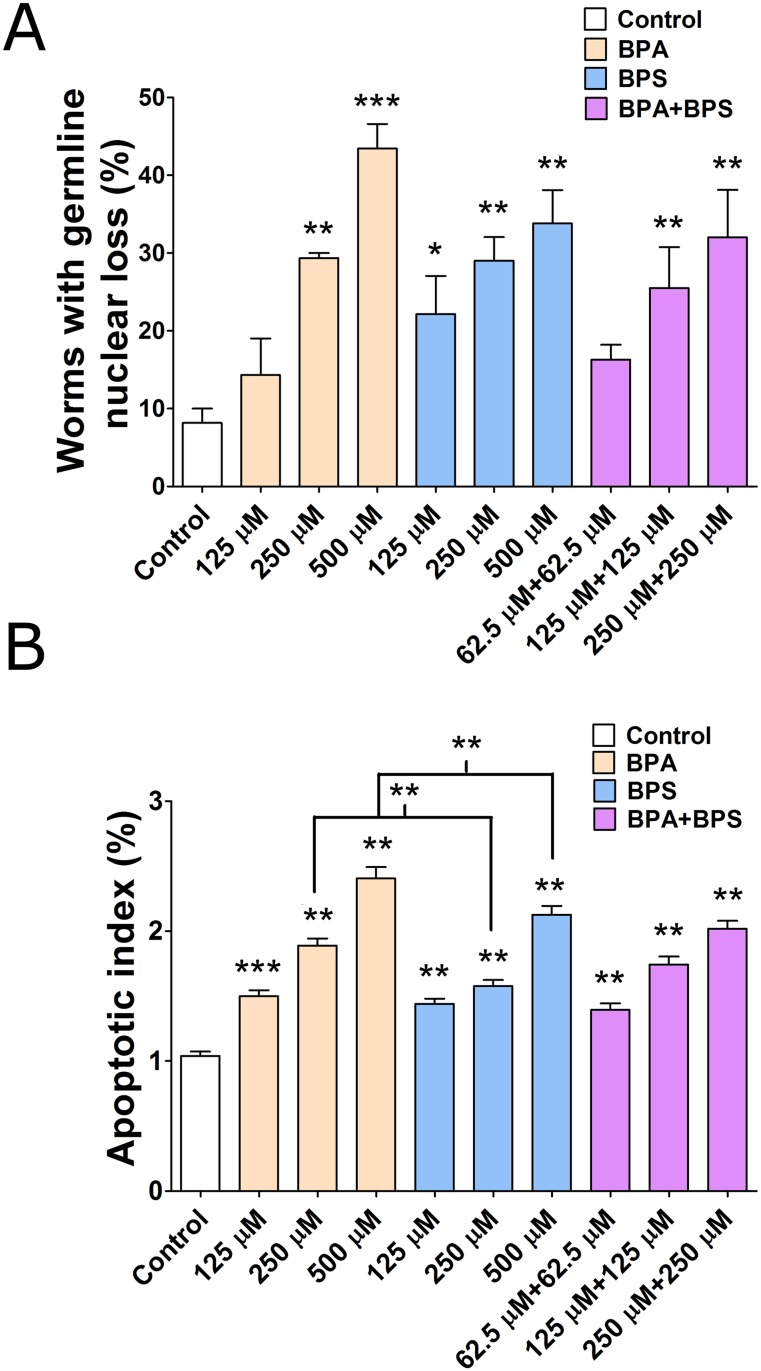
Bisphenols exposure induces germline nuclear loss and apoptosis.(A) Quantification of germline nuclear loss frequency in the gonad of worms exposed to vehicle or to the indicated doses of BPA and/or BPS. N = 20 worms per trial, three repeats per treatment group. (B) Apoptotic index, i.e. the number of apoptotic nuclei number per 100 pachytene nuclei in the gonad of worms exposed to vehicle control (0.1% ethanol) or to the indicated doses of BPA and/or BPS. N = 20 worms per trial, four repeats per treatment group. Error bars represent SEM. All tests are based on t statistics, calculated at each exposure concentration level *P<0.05, **P<0.01 and ***P≤0.001.